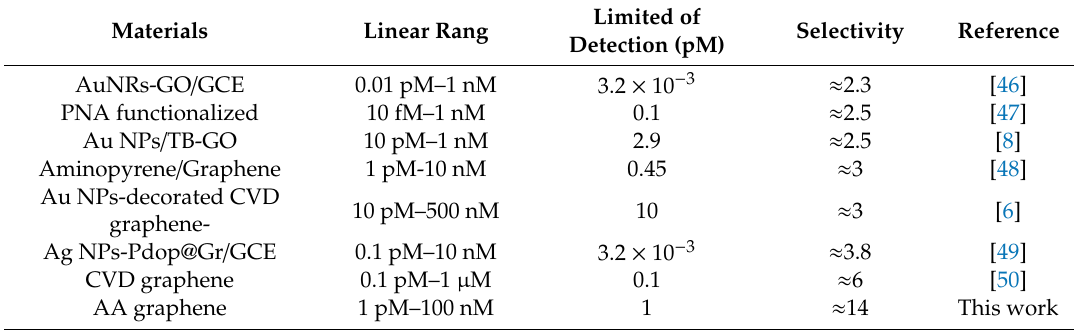
Table 2. Specificity comparison of biosensors based on graphene or graphene derivatives for label-free electrical or electrochemical detection of target